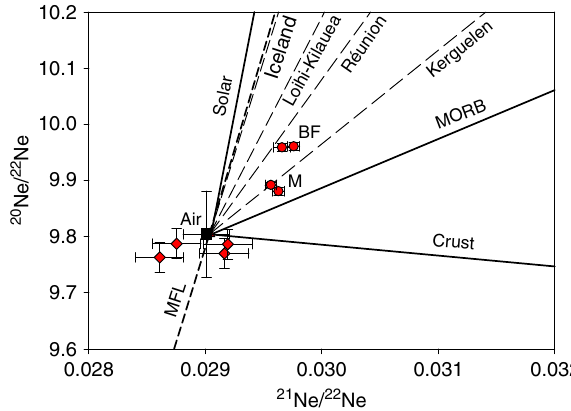
Fig. 4 20 Ne/ 22 Ne plotted against 21 Ne/ 22 Ne for the Bongwan CO 2 samples. Lower precision analysis performed on the MAP 215-50 mass spectrometer are plotted as red diamonds, higher precision analysis undertaken on the ARGUS VI mass spectrometer are depicted as red circles, with air plotted as a black square. 1 σ errors associated with each measurement are provided along with mixing lines between air 67 , continental crust 41 , MORB 46 and solar end members 62 shown as solid black lines. The Kerguelen, Reunion, Loihi-Kilauea, and Iceland hotspots are depicted as thin dashed lines 46 with the mass fractionation line (MFL) shown as a thick dashed line. The Baker Farm (BF) and Mjaja (M) gases plot above the established air-MORB mixing line 40,68 , plotting between the Kerguelen and the Reunion mantle source 25 , implying an undegassed mantle origin for the Bongwan CO 2 . The uncertainty differences re fl ect different analytical procedures and the ARGUS samples have been corrected for the contributions to 21 Ne from NeH + , which is controlled by the amount of H 2 present in the mass spectrometer during analysis 61 (see “ Methods ”